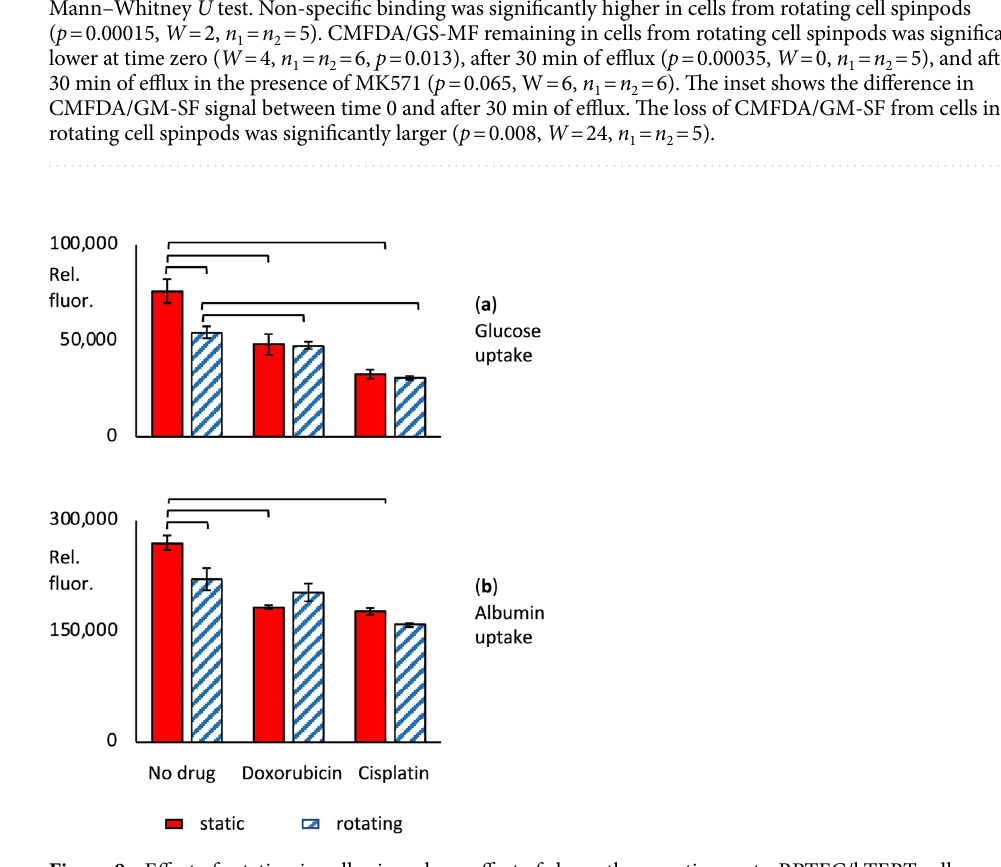
Figure 8. Effect of rotation in cell spinpods on effect of chemotherapeutic agents. RPTEC/hTERT cells on carrier beads were cultured in cell spinpods under rotating conditions ( ) or static conditions ( ) for two days in the presence of 5 µM doxorubicin, 100 µM cisplatin, or no drug control. Panel ( a ) shows the uptake of glucose, measured with the fluorescent substrate 2-NDBG. Panel ( b ) shows the uptake of FITC-albumin. Cells from all samples were trypsinized off the carrier beads before analysis by flow cytometry. Data is presented as mean fluorescence ± SEM of six replicates (except for 5 replicates with static cisplatin), in relative fluorescence units. Brackets mark where differences in the distributions between groups were statistically significant, e.g. p < 0.05, by one-tailed Mann–Whitney U